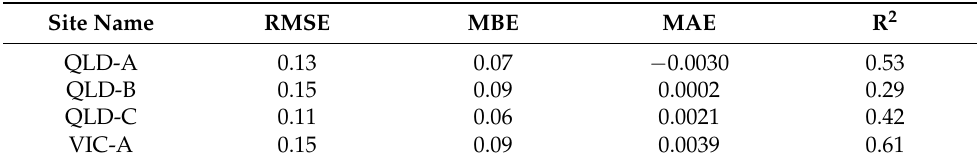
Table 5. Error Metrics for predicted cloud index at advection of 5 min.